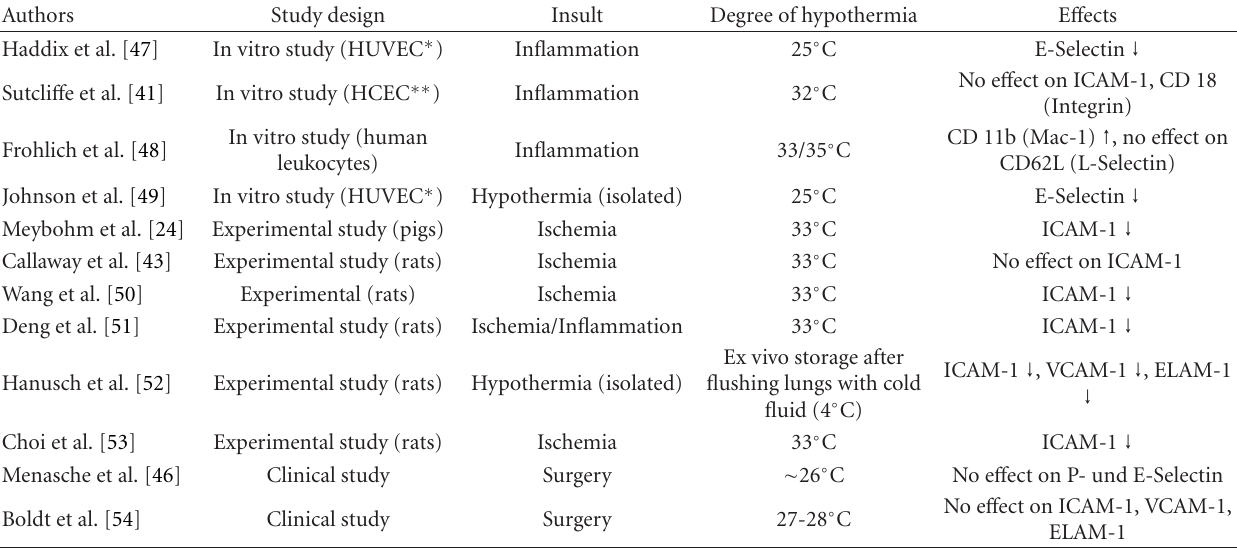
∗ human umbilical vein endothelial cells. ∗∗ human cerebral endothelial